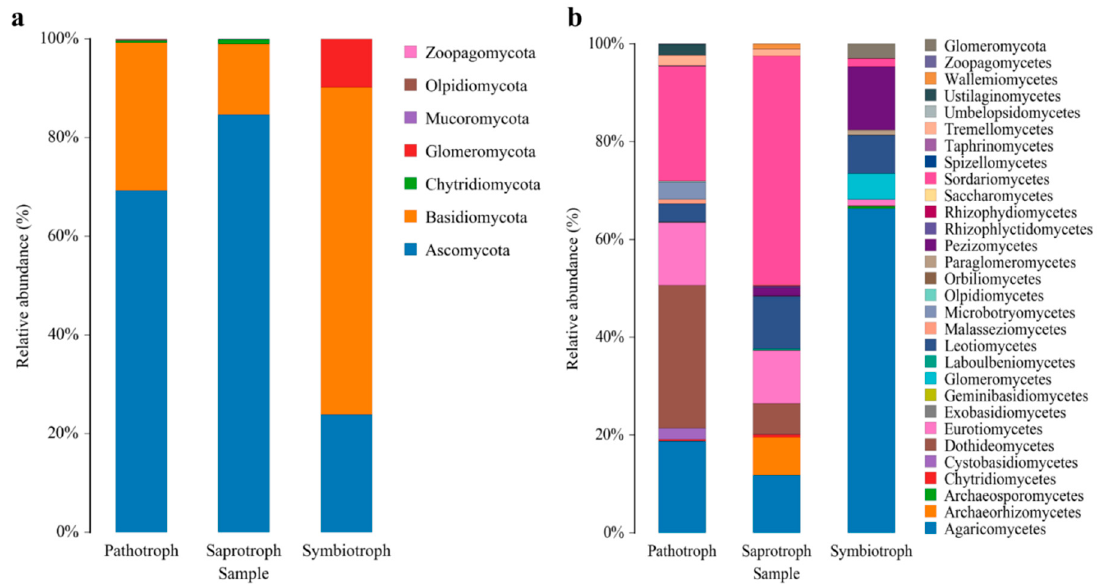
Figure 6. Relative abundance of the pathotroph, saprotroph, and symbiotroph functional fungi at the phylum ( a ) and class ( b ) levels in the samples.